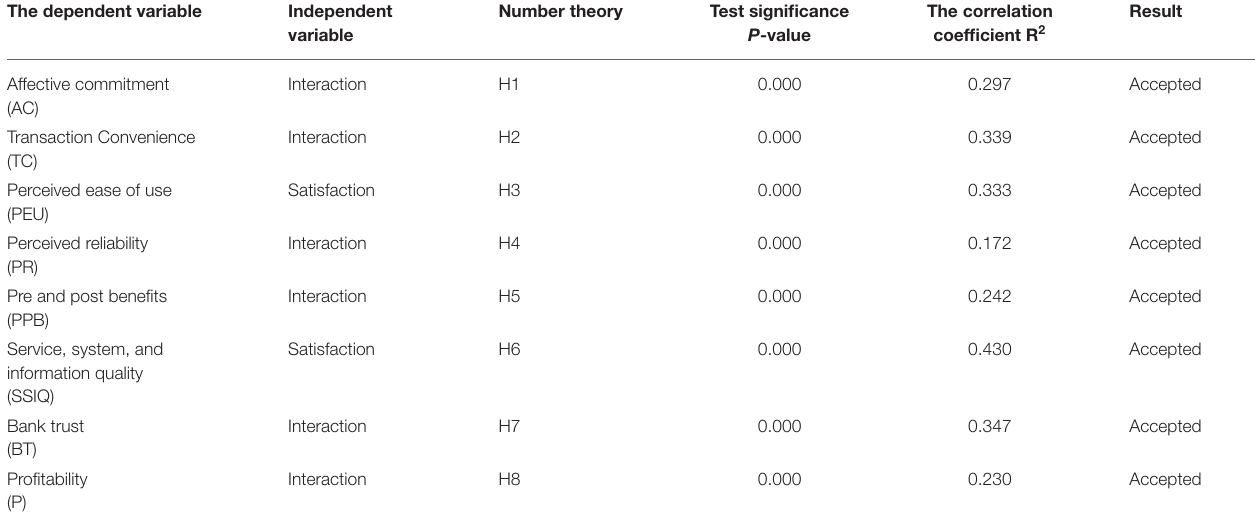
TABLE 5 | The results of the linear regression